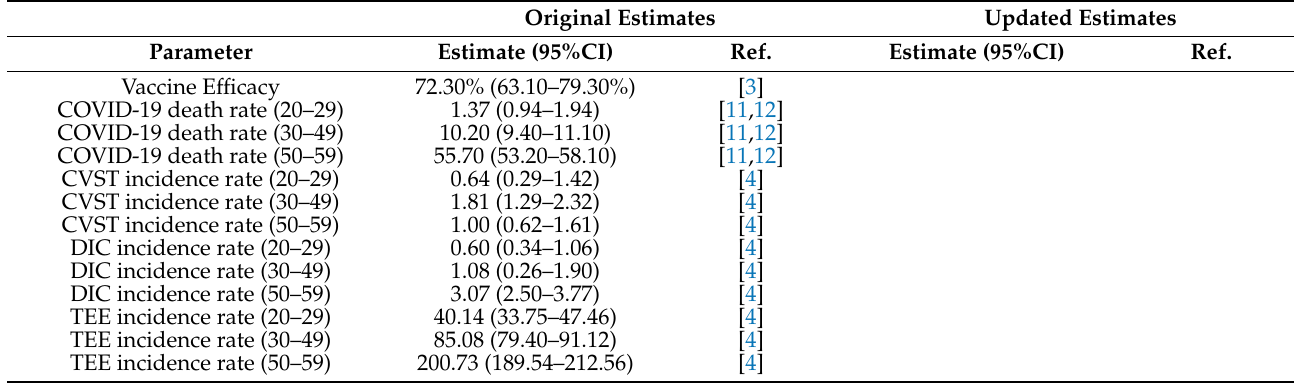
Table 1. Parameters used for Monte Carlo